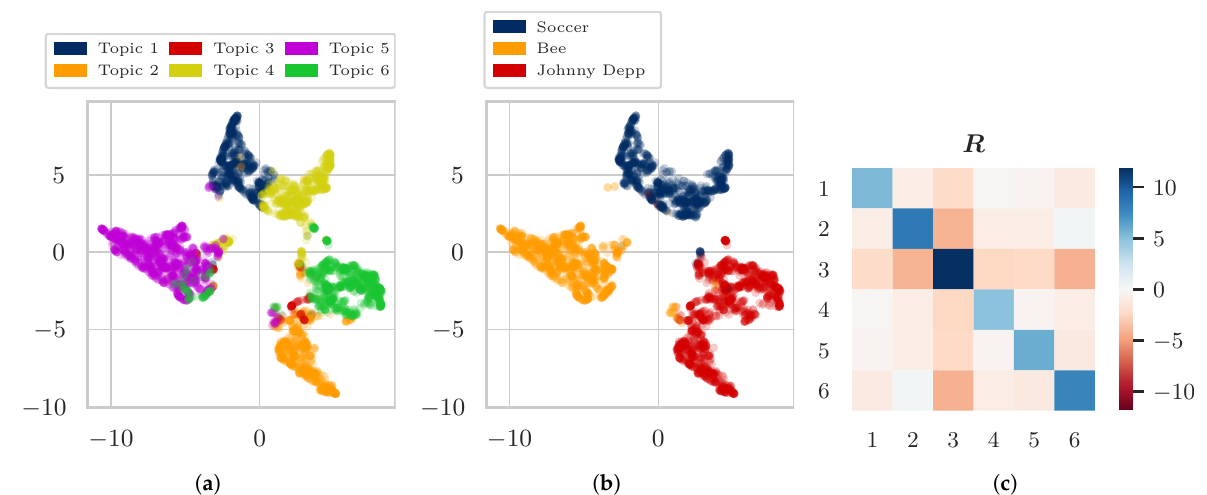
Figure 5. ( a ) 2-dimensional representation of word embeddings A (cid:48) colored by topic assignment. ( b ) 2-dimensional representation of word embeddings A (cid:48) colored by original Wikipedia article assignment (words that occur in more than one article are excluded). ( c ) Colored heatmap of affinity matrix R